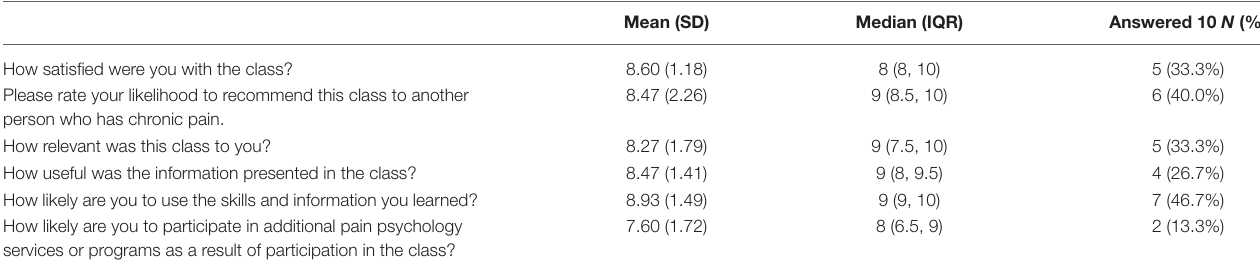
TABLE 2 | Responses from the 15 patients who completed the satisfaction survey (mean and standard deviation, median and interquartile range, and the number and percent of patients who answered 10 for the six numeric scale questions). Mean (SD) Median (IQR) Answered 10 N (%) How satisfied were you with the class? 8.60